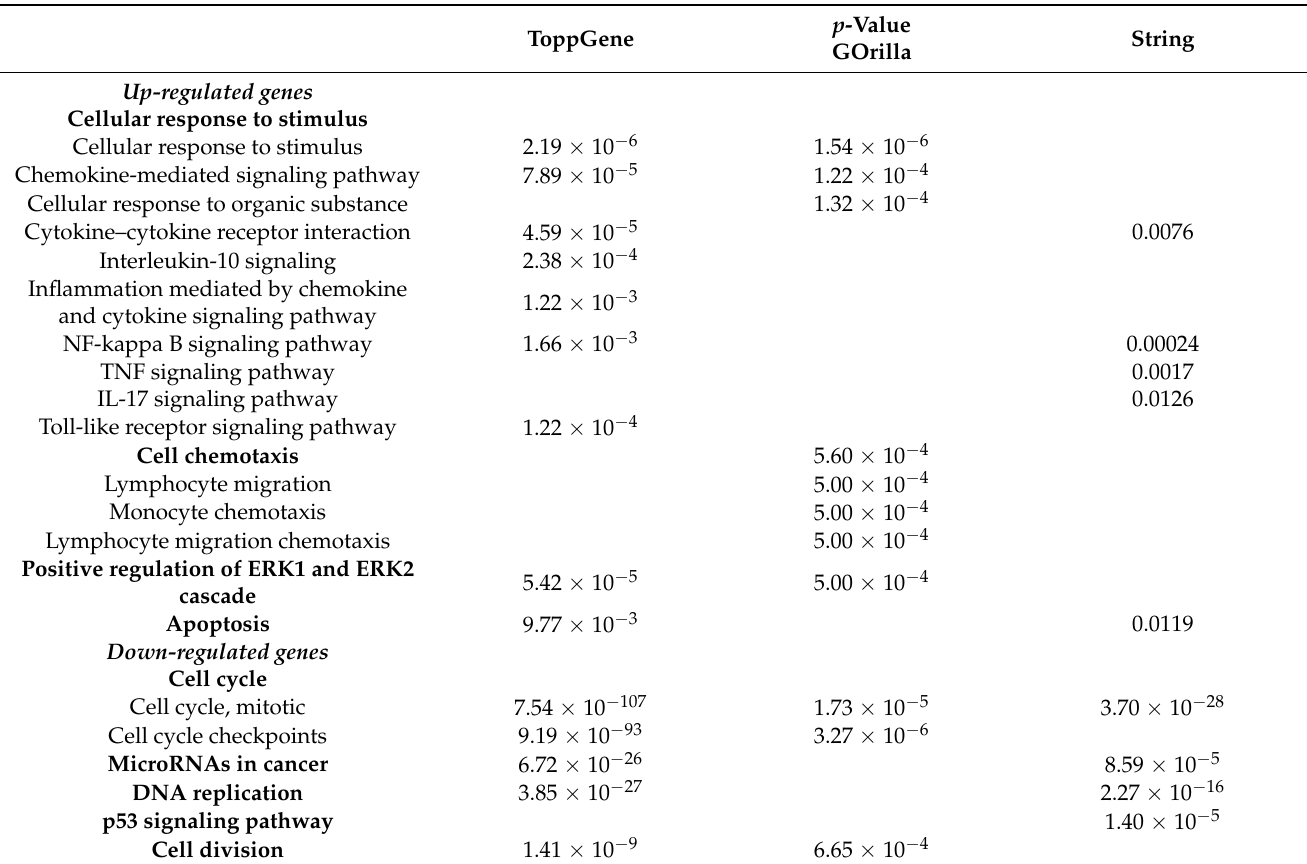
Table 1. Gene ontology (GO) analyses of the genes regulated in response to the activation of LAD2 cells by A549-TMVs.